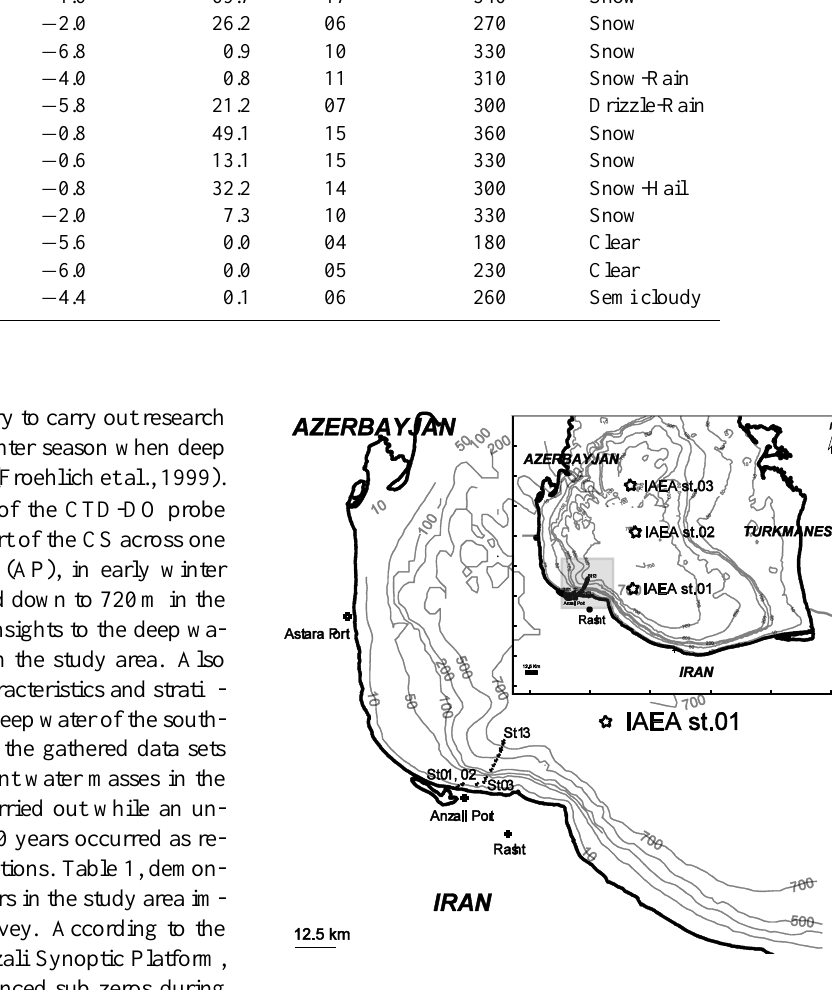
Table 1. Statistics of meteor-parameters prior and after to field survey from 16–27 January 2008 (I. R. of Meteorological Org, 2008). Day Air Temp Air Temp Precipitation Wind Speed Wind Direction Weather Jan 2008 (max) (min) (cm) (max) (degree) Condition